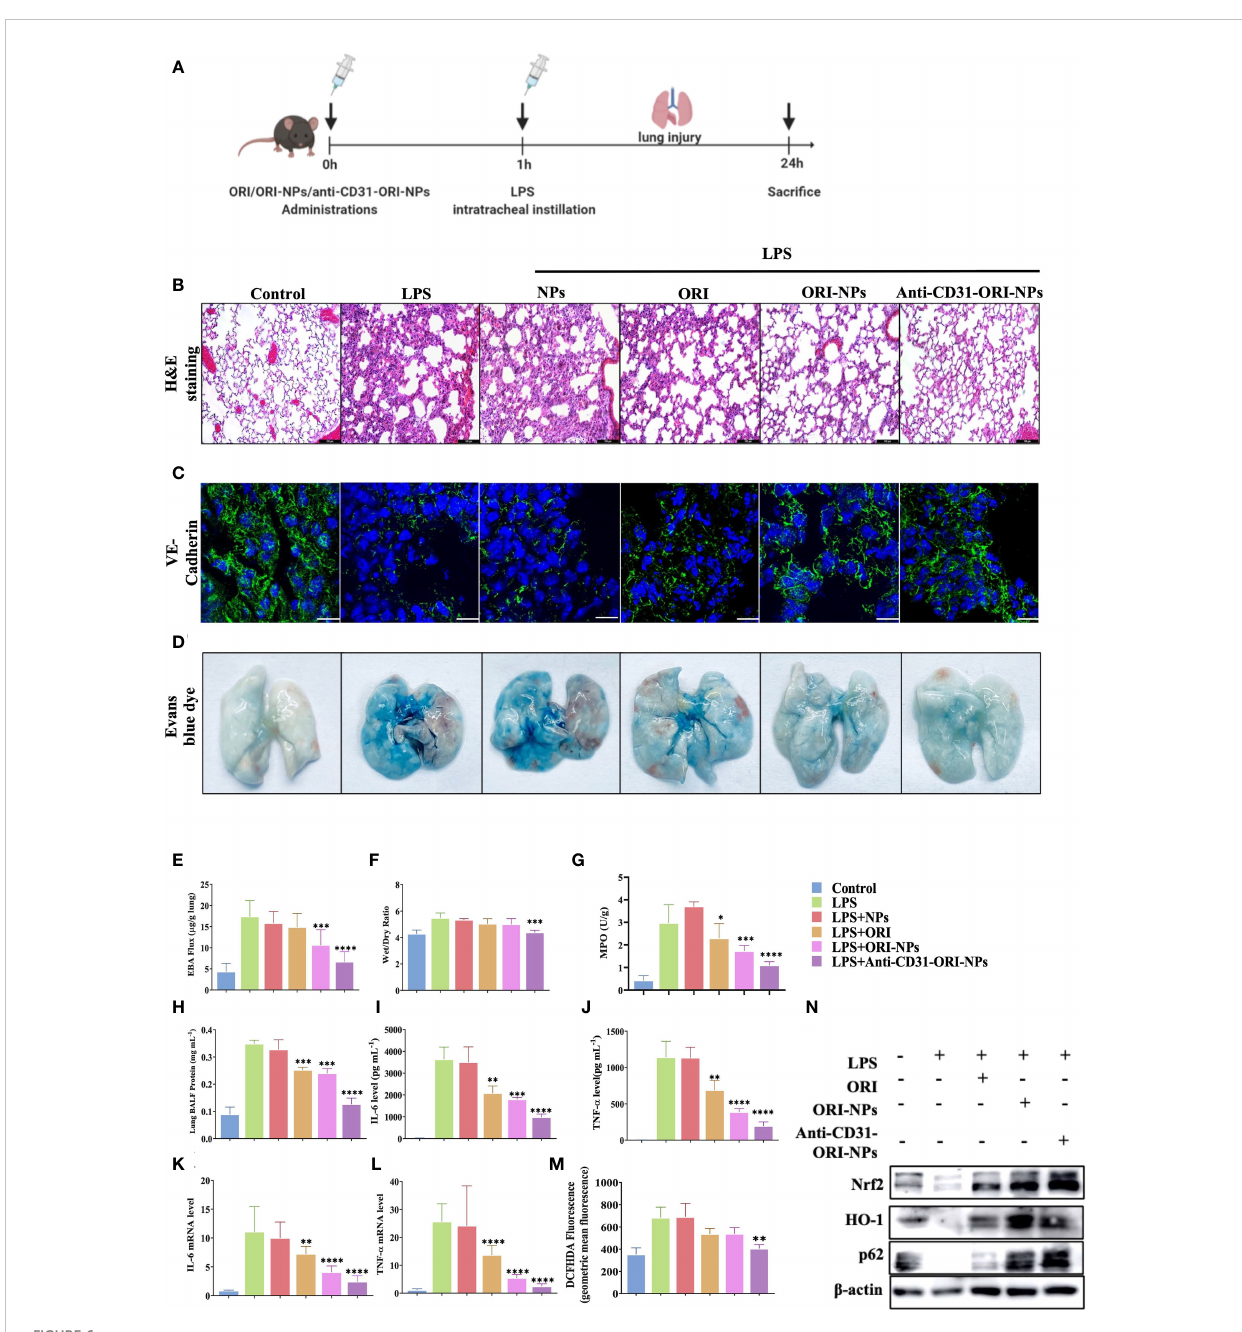
FIGURE 6 Anti-CD31-ORI-NPs increases the anti-in fl ammatory effect to treat ALI in vivo via selectively accumulated in the lung tissues. (A) C57BL/6 mice (n=10) were intravenously injected 5 mg kg -1 NPs, ORI, ORI-NPs and anti-CD31-ORI-NPs for 1 hour, respectively. Mice were then intratracheally injected with 2.5 mg kg -1 LPS. Mice were sacri fi ced and the tissues were collected. (B) Representative histological section of the lungs was stained with hematoxylin and eosin. Bars: 100 m m. Magni fi cation ×200. (C) The sections of lung tissues were prepared to determine the expression level of VE-cadherin with fl uorescence-conjugated secondary antibodies (green). DAPI (blue) counterstains cell nucleus. Bars: 50 m m. (D, E) The pulmonary vascular permeability of lung tissues was evaluated and quanti fi ed by Evans blue extravasation assay. (F) The wet-to-dry ratios of lungs derived from different treatment groups were calculated. (G) The neutrophil migration and in fi ltration were determined by measuring MPO activity. (H) The protein concentration in BALF was quanti fi ed using Bradford protein assay. (I, J) The secretion of IL-6 and TNF- a in BALF were determined by ELISA. (K, L) The mRNA expression of IL-6 and TNF- a in lungs was quanti fi ed by QRT-PCR. (M) ROS production in the lung tissues was analyzed by fl ow cytometry. (N) The expression of Nrf2, p62, HO-1, and b -actin in the lung tissues with indicated treatments were examined by western blot. Data were expressed as mean ± S.E.M. * p< 0.05, ** p < 0.01, *** p < 0.001 and **** p< 0.0001, compared to the LPS-stimulated